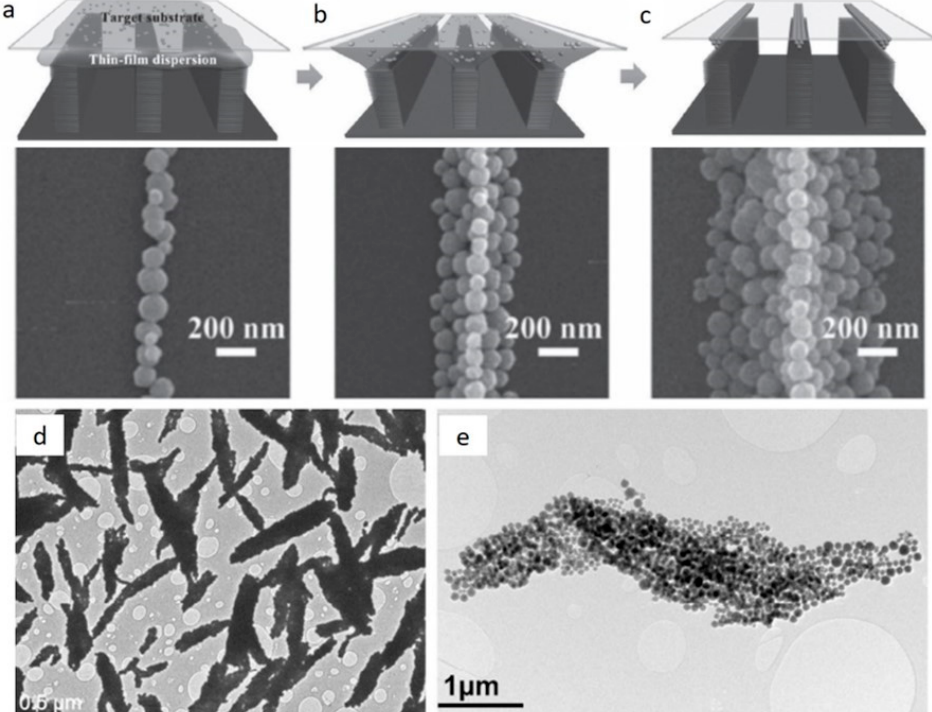
Figure 9. ( a – c ) Schematic illustration of a method for fabricating striped patterns of magnetic nanoparticles. ( a ) Template consisting of elongated ridges and gaps, and a flat target substrate. ( b ) After suspension deposition, water is evaporated and the film is divided in the sections along the ridges of the template. ( c ) 1D arrangement of the nanoparticles. Reproduced with permission from [107], Copyright 2016, with permission from Wiley. ( d , e ) Colloidal approach for the magnetic structuring in suspension. Reproduced with permission from [28], Copyright © 2021, with pemission from American Chemical Society. ( d ) Low-magnification TEM image of anisotropic magnetic nanobun-